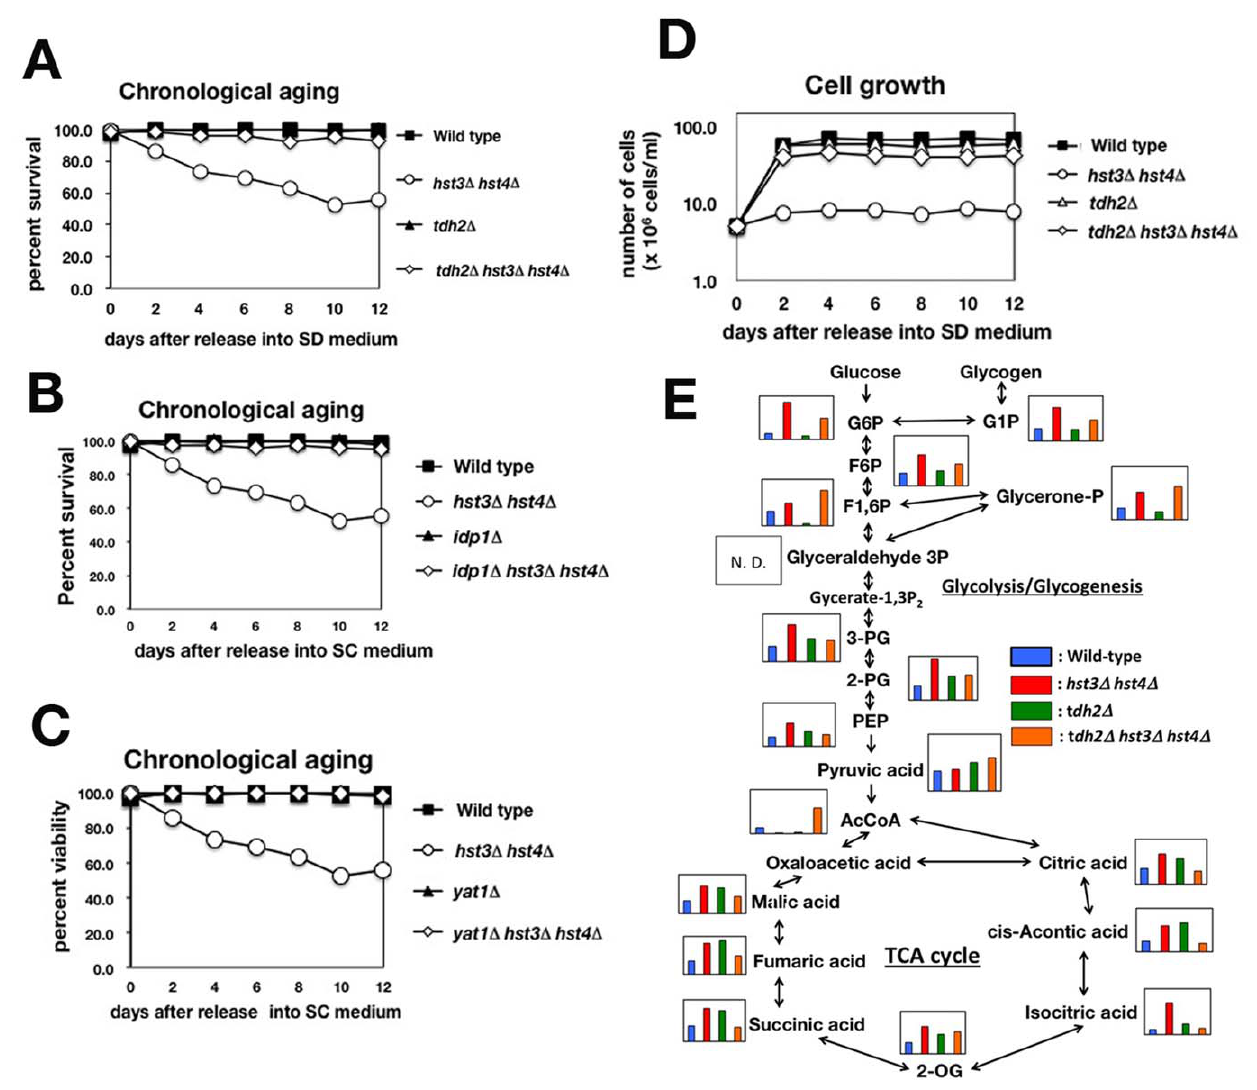
Figure 3. Deletion of the TDH2 gene restores both CLS and vegetative growth and reduces the metabolic intermediates of glucose metabolism in hst3 D hst4 D cells. (A) The CLSs of wild type, hst3 D hst4 D , tdh2 D and tdh2 D hst3 D hst4 D cells. (B) The CLSs of wild type, hst3 D hst4 D , tdh2 D and tdh2 D hst3 D hst4 D cells. (C) The CLSs of wild type, hst3 D hst4 D , tdh2 D and tdh2 D hst3 D hst4 D cells. (D) Growth curves of wild type, hst3 D hst4 D , tdh2 D and hst3 D hst4 D tdh2 D cells in SC medium. (E) The metabolic profiling data of central carbon metabolism in wild type, hst3 D hst4 D , tdh2 D and hst3 D hst4 D tdh2 D cells were mapped onto known pathways. Each graph was derived from the calculated amount of metabolic intermediates shown in Table